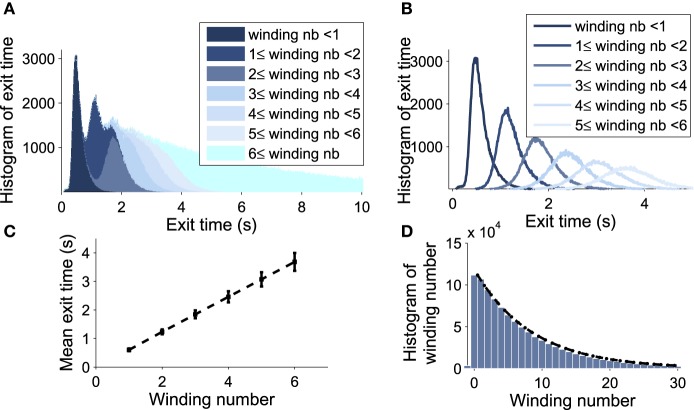
Decomposition of the DTUS with respect to the winding number. (A) Distribution of exit times. (B) Distribution of exit times conditioned on the winding number. (C) Mean exit time and variance increase linearly with the winding number. (D) Exponential approximation of the winding probability. The probability of escaping after n turns is f(n) = p(1−p)n−1, where p is computed empirically as the ratio of trajectories making one turn to the total number. We use 106 runs, trajectories start at (μ0, V0) = (0.21, 20mV) with σ = 0.0015.